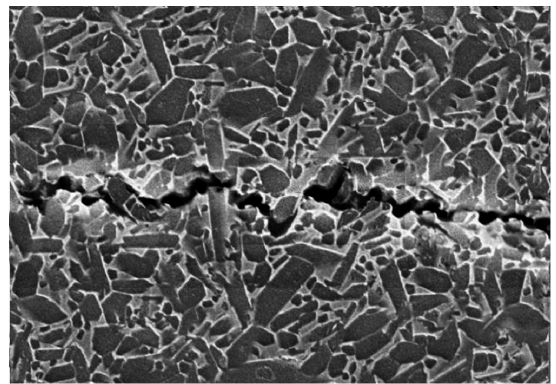
Figure 7. GCA crack propagation